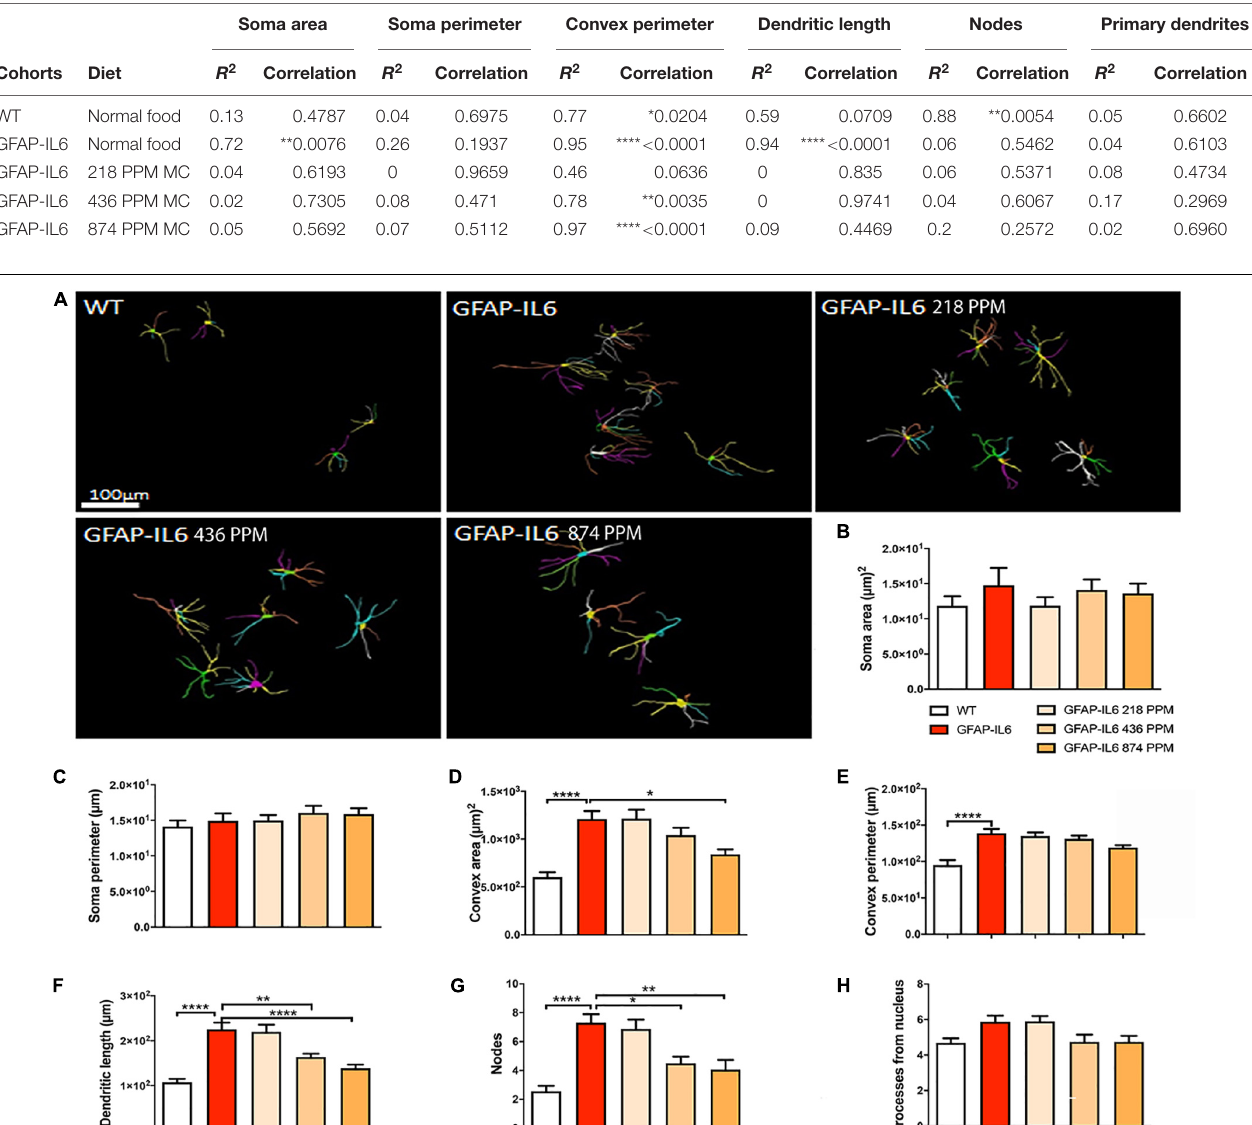
TABLE 5 | Bivariate correlation of morphological characteristics with overall microglial cell size in cerebellum. Soma area Soma perimeter Convex perimeter Dendritic length Nodes